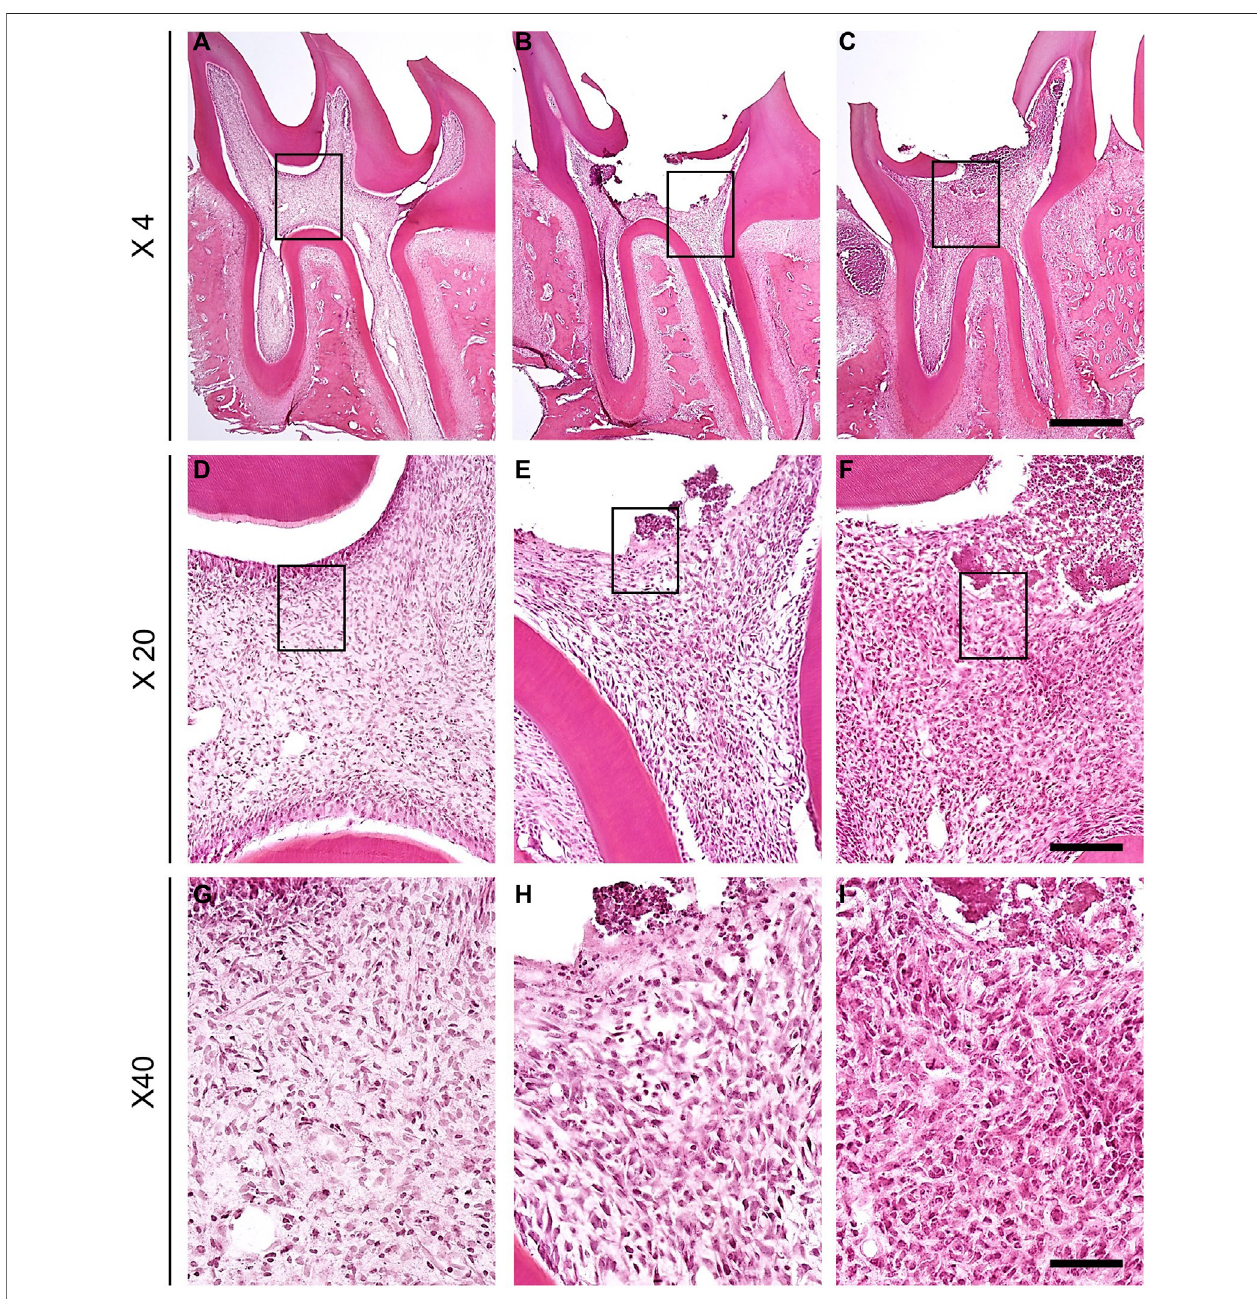
FIGURE1| Comparisonofcross-sectionofnaïve,saline-treatedandmolarexposedtoAITC.Naïve (A) ,saline-injected (B) ,andAITC-injected (C) pulptissueswere compared (Scale bar (cid:1) 200 μ m). H&E-stained sections of naïve, saline-treated, and in fl amed dental pulp tissue veri fi ed the progression of in fl ammation. (D – F) Figures present enlarged black squares in (A – C) (Scale bar (cid:1) 50 μ m). (G – I) Figures indicate enlarged black squares in (D – F) (Scale bar (cid:1) 10 μ m). Figures indicate the AITC- induced pulpal neutrophil changes.